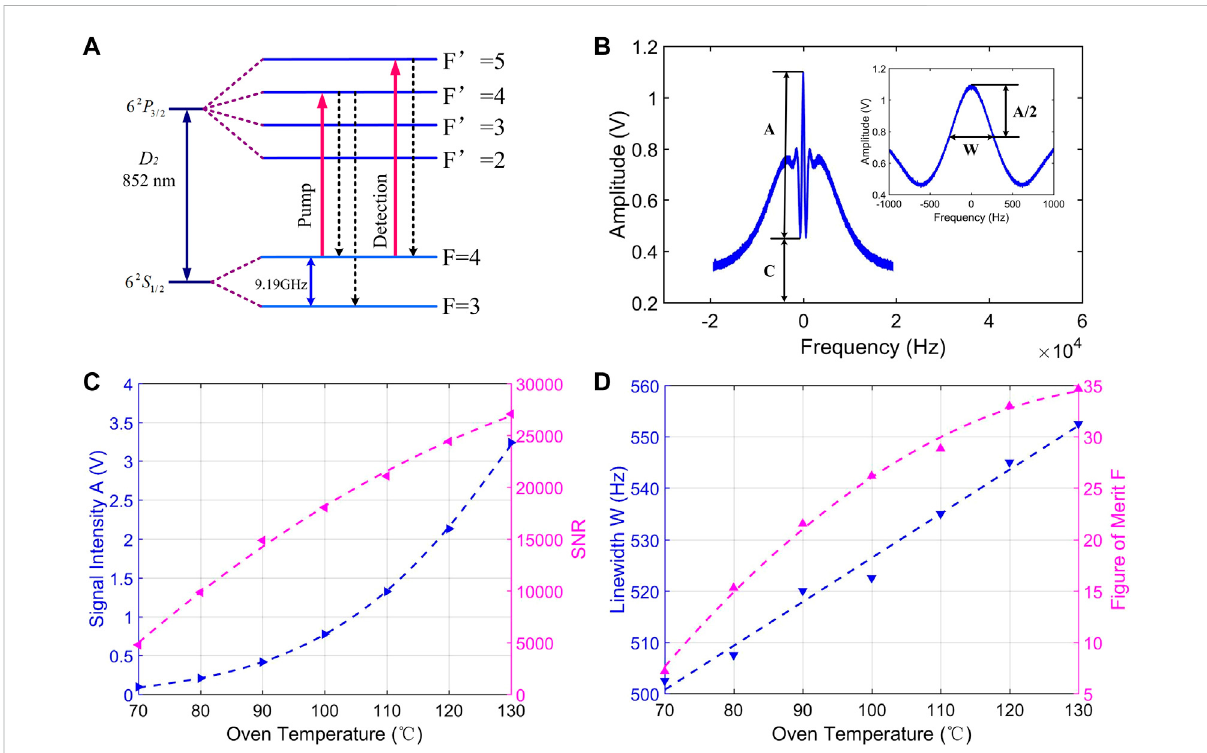
FIGURE 2 Energy levels and experimental results of OPCBT without HMF. (A) Relevant energy levels of cesium, |F = 4 > → |F ’ = 5 > is cycling transition. (B) Ramsey fringes of the microwave clock transition, |F = 3, m F = 0 > → |F = 4, m F = 0 > . (C) Measured signal intensity A (blue triangles) and SNR (purple triangles)in1 HzbandwidthattheCsoventemperatureof70 – 130 ° C. (D) MeasuredlinewidthW(bluetriangles)andFigureofmeritF(purpletriangles) at the Cs oven temperature of 70 – 130 ° C.